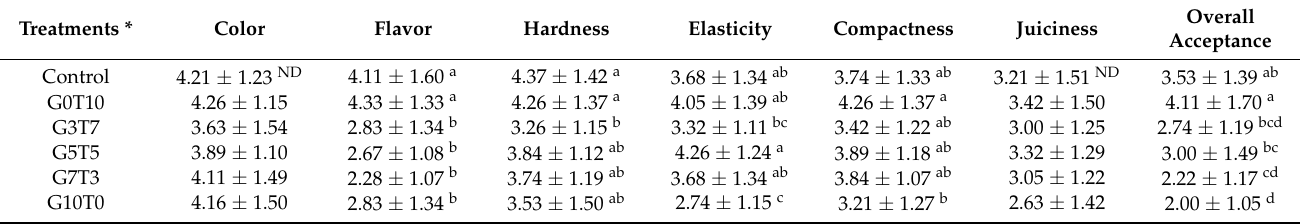
Table 5. Preference of sensory properties of PBMPs with different